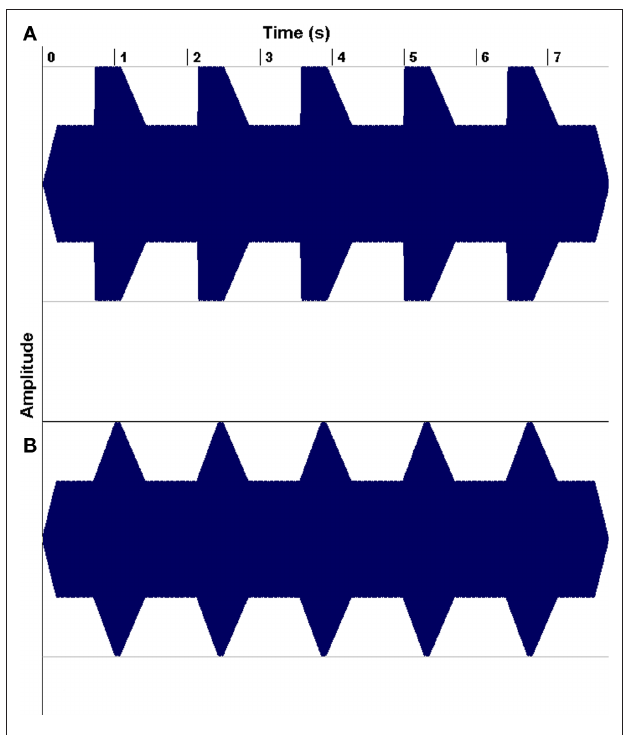
FiguRE 8 | Examples of non-linguistic tonal stimulus waveforms for rise times of 15 (A) and 300 ms (B). From Goswami et al. (2002), reproduced